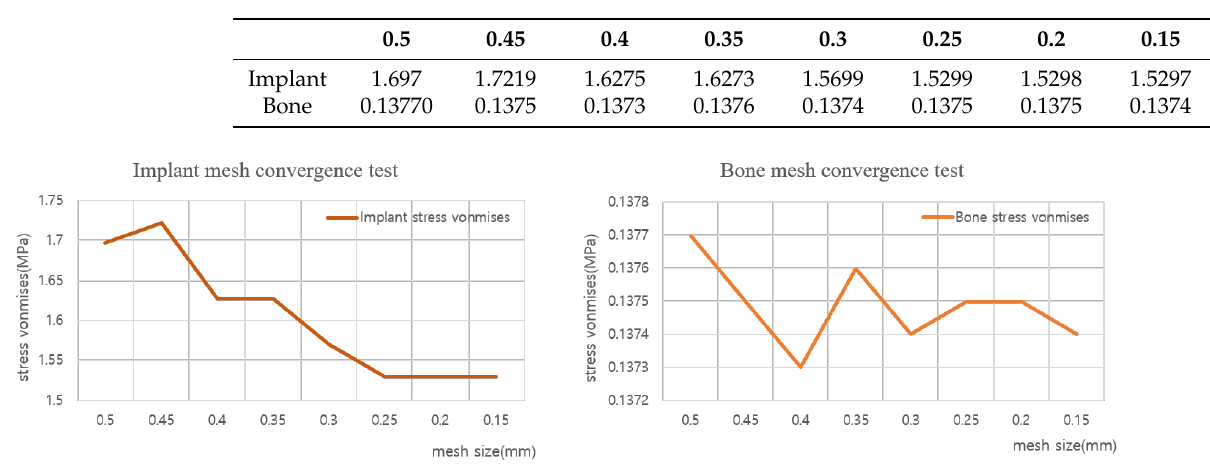
Figure 6. Implant, bone mesh. Table 3. Mesh convergence test result.